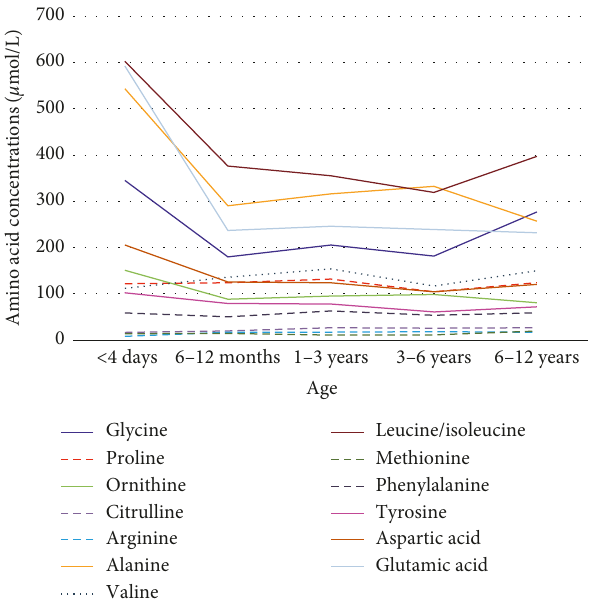
Figure 1: Trends of the age-specific distribution of each amino acid median